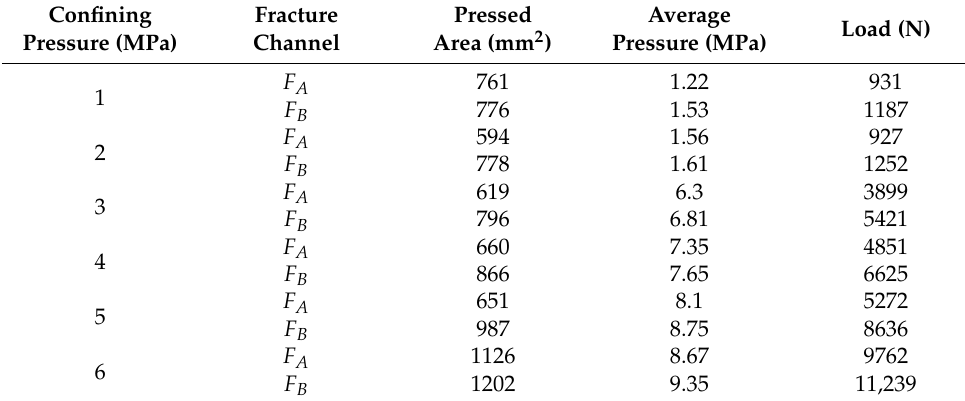
Table 3. Stress response of pressure film under